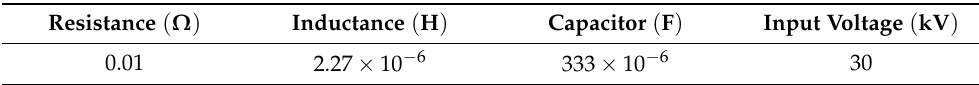
Table 3. Current circuit parameters of